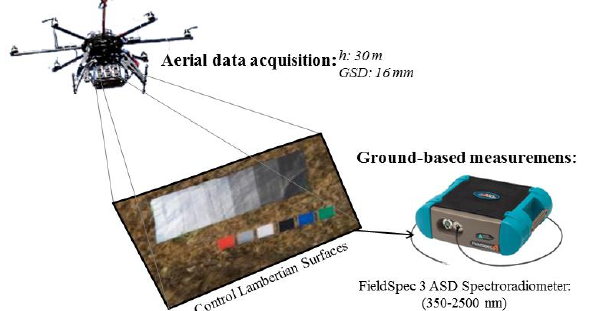
Figure 2. Sketch of the multispectral data acquisition performed to radiometrically calibrate the Mini-MCA6